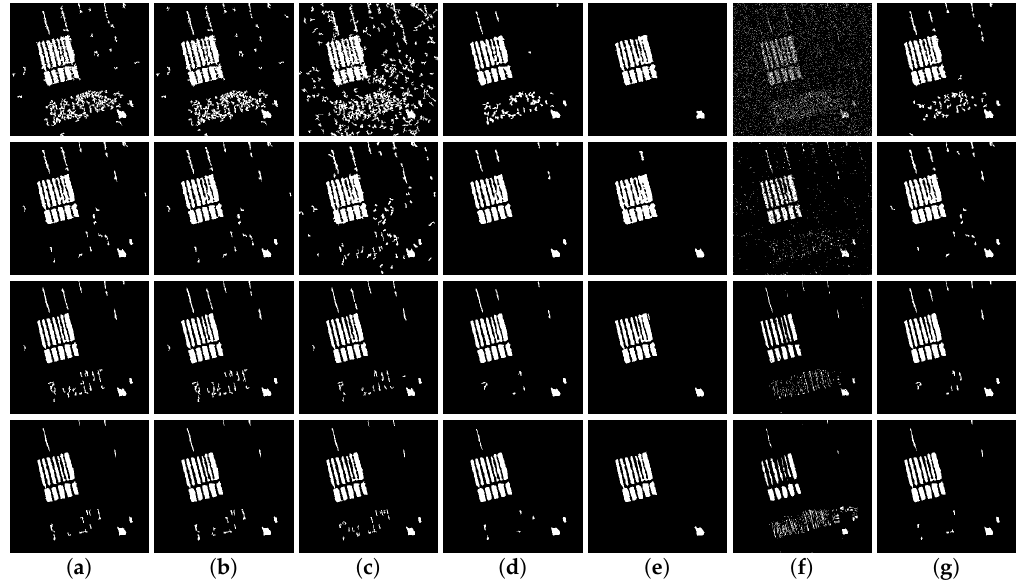
Figure 10. Results of ( a ) PCAK, ( b ) SPC, ( c ) FCM-MRF, ( d ) GTLC, ( e ) SACD, ( f ) Conradsen, and ( g ) SC-SGD on Yellow River B dataset. From top to bottom: each row contains the results of the input image, and images filtered by MMSE, SAR-BM3D, and PPB filters,